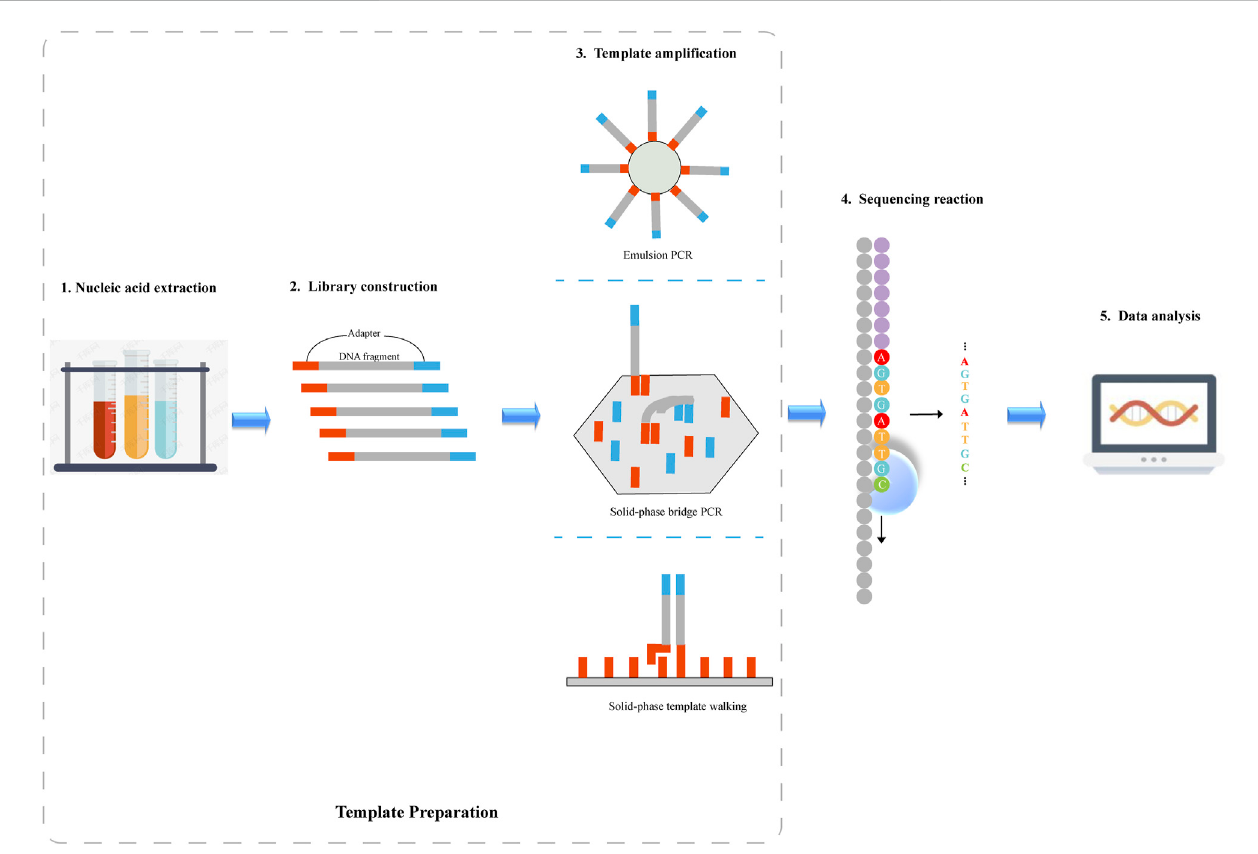
FIGURE 1 Schematic diagram of next-generation sequencing. 1) Nucleic acid is extracted from the sample. 2) DNA fragments are sheared into smaller fragments through sonication or enzymatic fragmentation, and then the sheared DNA is ligated to adapter sequences where DNA sequencing is initiated. 3) Following library preparation, DNA fragments are ampli fi ed by PCR. Depending on the sequencing platform, emulsion PCR, solid-phase bridge PCR or solid-phase templatewalkingisusedtogenerateclonaltemplatepopulations.4)DNAsequenceinformationisobtainedbyasequencingplatform.5)Thesequencing data is analyzed by various